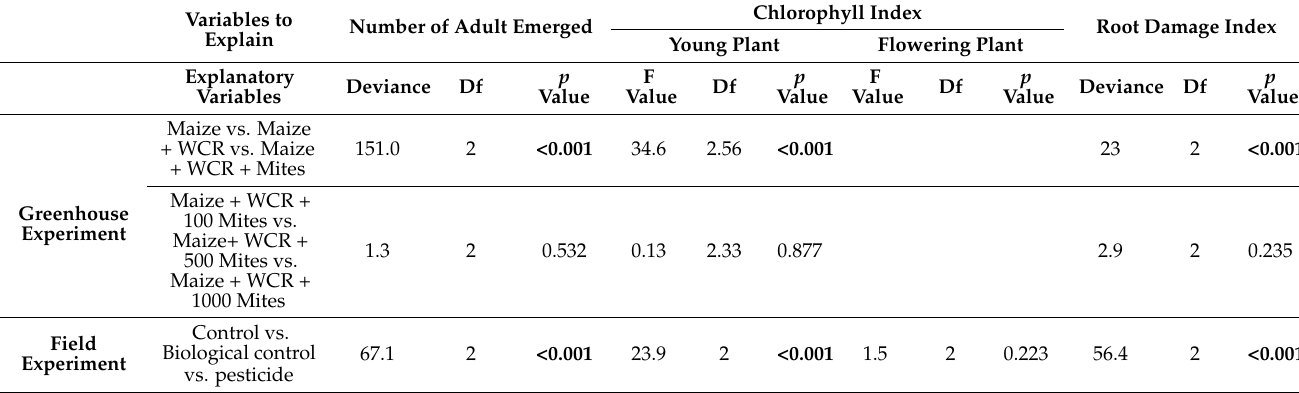
Table 1. Results of Linear (F value) and Generalized Linear Model ( χ 2 deviance) on the number of adult D. virgifera virgifera emerged per plant, the nitrogen content of plant, and the root damage index (IOWA) in both greenhouse and field. Factors included in the models are described as explanatory variables. Significant effects are indicated in bold text. Df correspond to the degree of